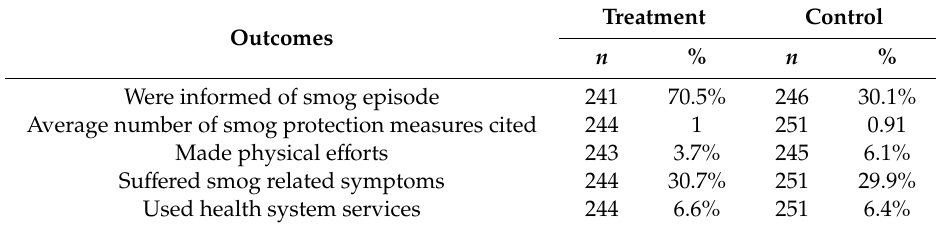
Table 3. Ex post measurement of outcomes measured by binary variables.